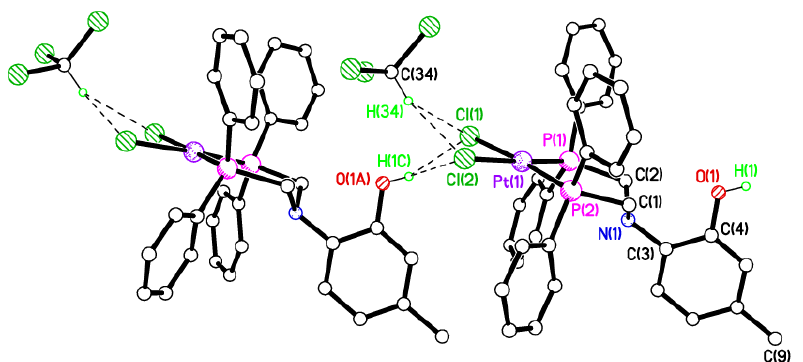
Figure 6. H-bonded packing arrangement in the crystal structure of 4c · CHCl 3 . Most H atoms omitted for clarity. Symmetry operator A = x+½, –y+½, z+½. Table 9. Selected data ( D ··· A /Å, ∠ D –H ··· A / ◦ ) for key inter- and intramolecular contacts for compounds 4b · (CH 3 ) 2 SO Table 5. Details of the X-ray data collections and refinements for compounds 4b·(CH 3 ) 2 SO , 4c·CHCl 3 , 4d·½OEt 2 , and